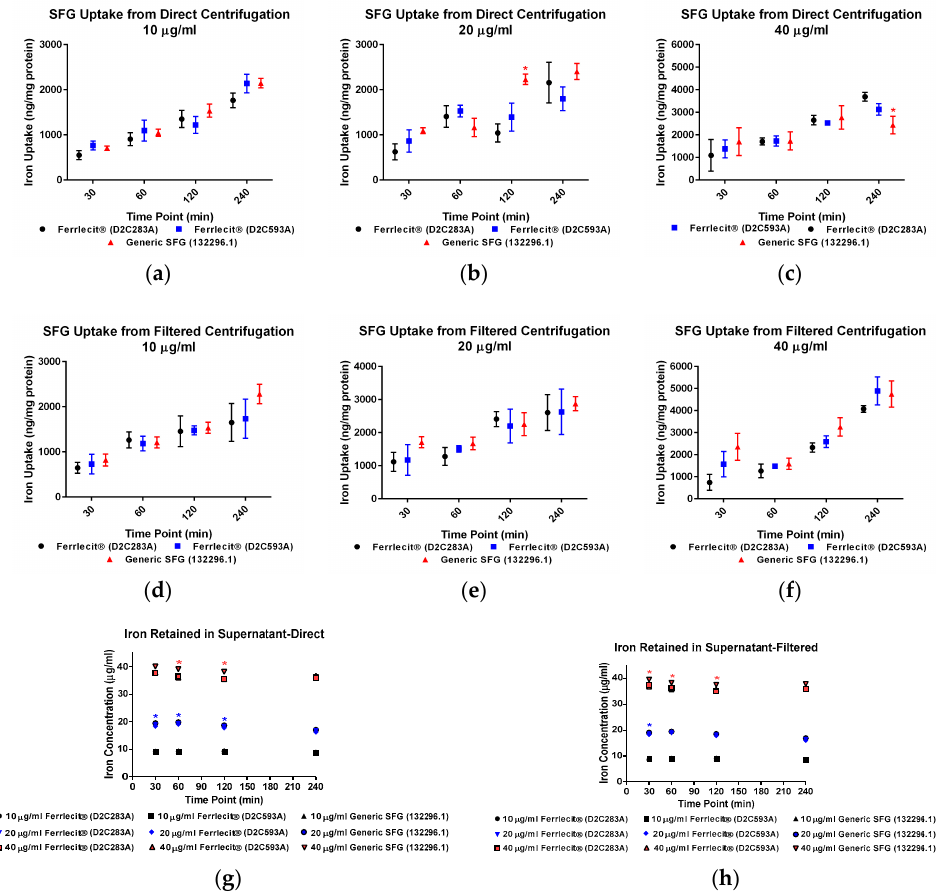
Figure 1. Comparison of iron uptake in THP-1 cells. Data are presented as mean ± SD ( n = 3, three independent experiments with four replicates for each experimental condition). A p -value < 0.05 was considered statistically significant, marked with *. ( a ) Iron uptake in THP-1 cells treated with 10 µg/mL drugs was measured from direct centrifugation harvest; ( b ) iron uptake in THP-1 cells treated with 20 µg/mL drugs was measured from direct centrifugation harvest; ( c ) iron uptake in THP-1 cells treated with 40 µg/mL drugs was measured from direct centrifugation harvest; ( d ) iron uptake in THP-1 cells treated with 10 µg/mL drugs was measured from filtered centrifugation harvest; ( e ) iron uptake in THP-1 cells treated with 20 µg/mL drugs was measured from filtered centrifugation harvest; ( f ) iron uptake in THP-1 cells treated with 40 µg/mL drugs was measured from filtered centrifugation harvest; ( g ) iron retained in cell culture supernatant was measured from direct centrifugation harvest; ( h ) iron retained in cell culture supernatant was measured from filtered centrifugation harvest.